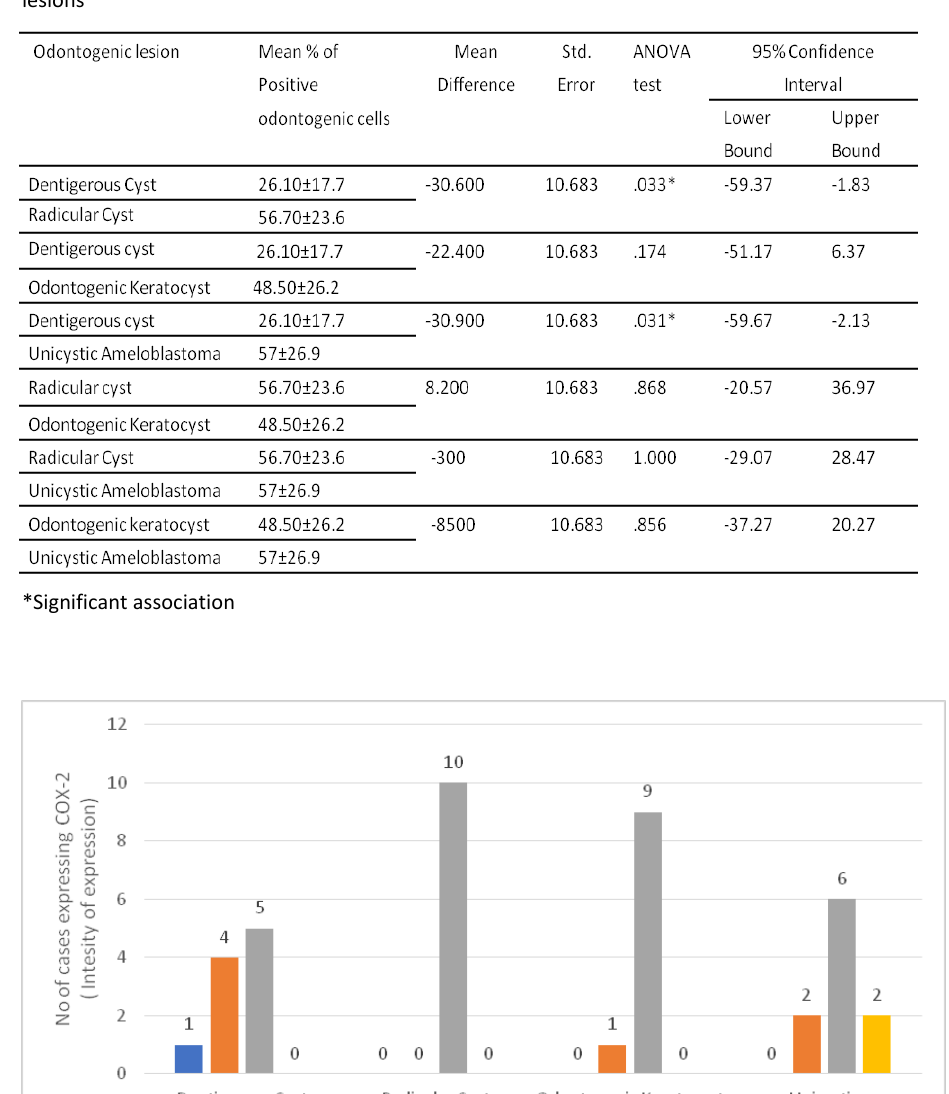
Table 2. Comparison of the mean % of positive odontogenic cells among the different odontogenic